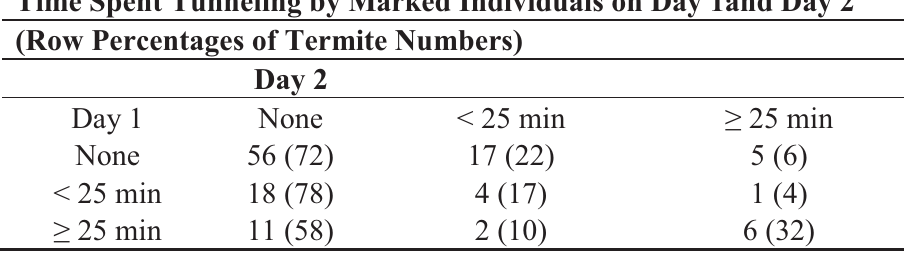
Table 4. Number of termites in three categories of time spent tunneling (none, < 25 min, ≥ 25 min) in each 1 -h tunneling trial conducted on consecutive days for four groups of 30 workers, two groups for each